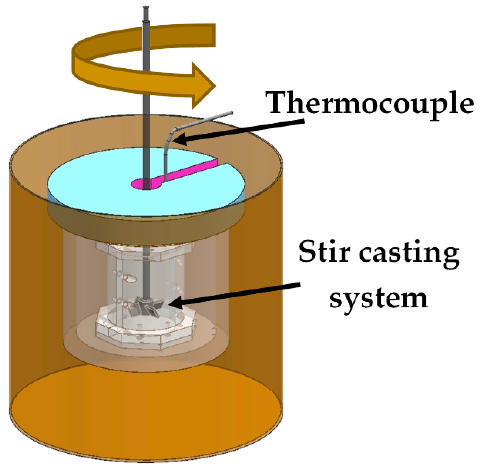
Figure 2. Experimental system for metallic foam